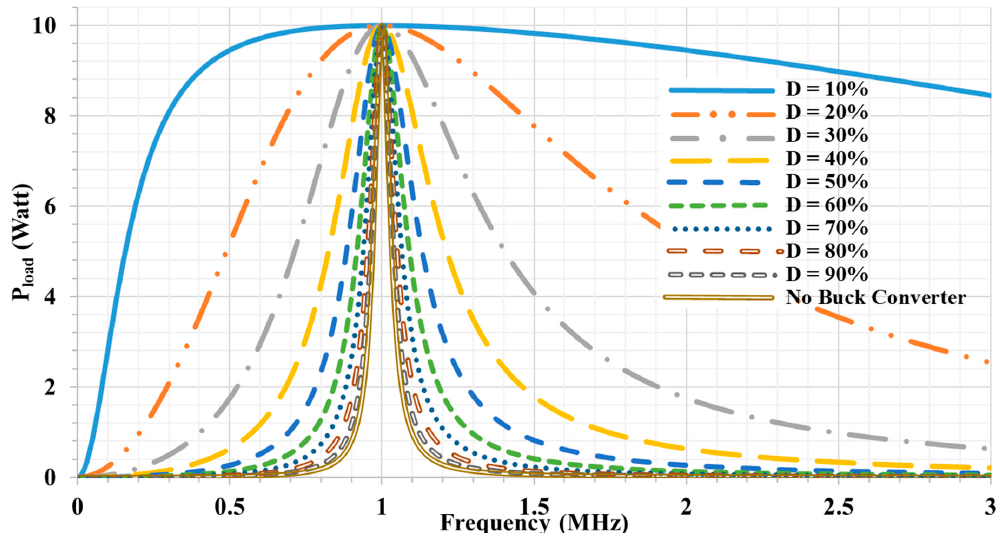
Figure 4. The frequency response of the output power at different duty cycles D .